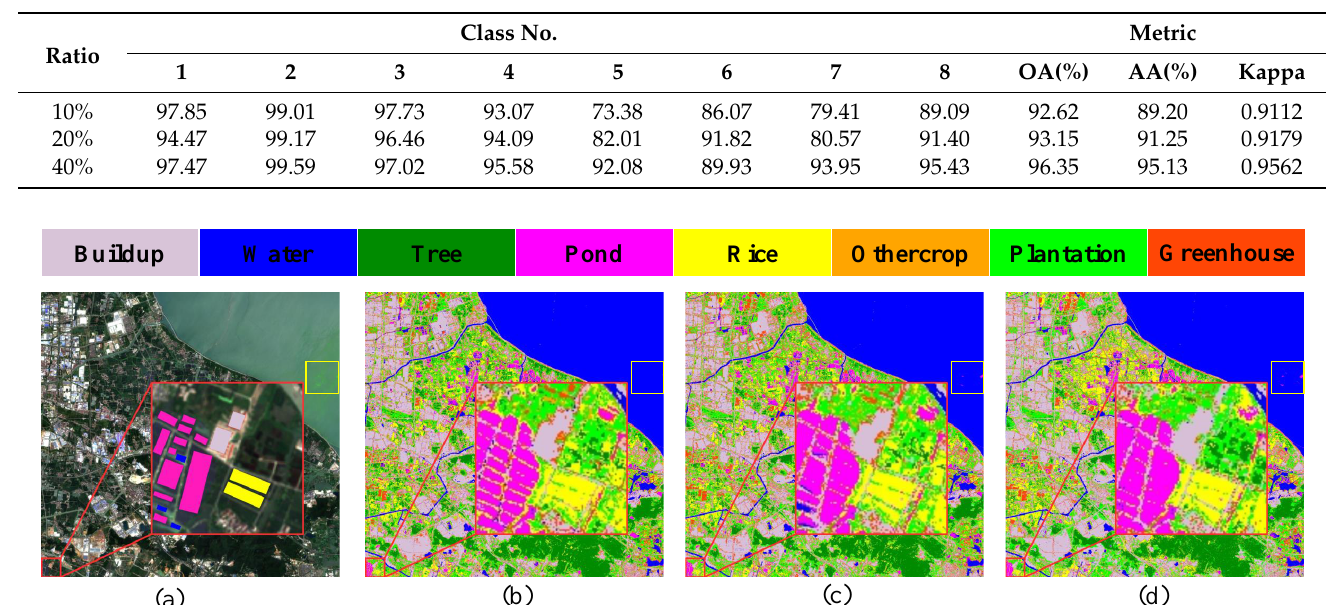
Table 5. HyFormer test results using different training sample proportions in the 2022 Changxing County testing set.